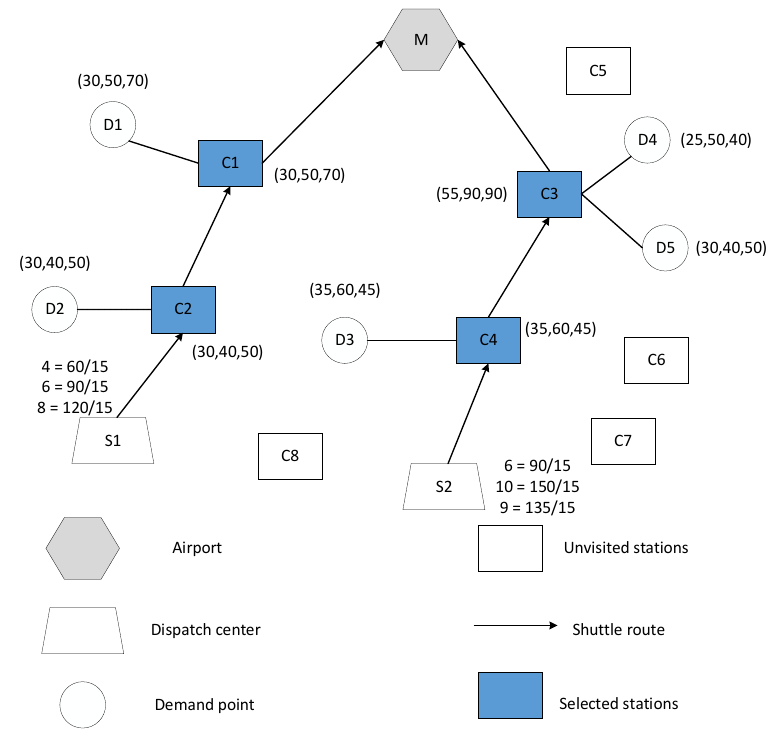
Figure 2. Typical example of the proposed